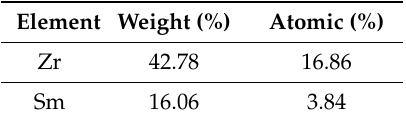
Table 2. Quantitative EDS analysis results obtained from point 2 on the surface of the sample presented in Figure 6 (only for Zr and